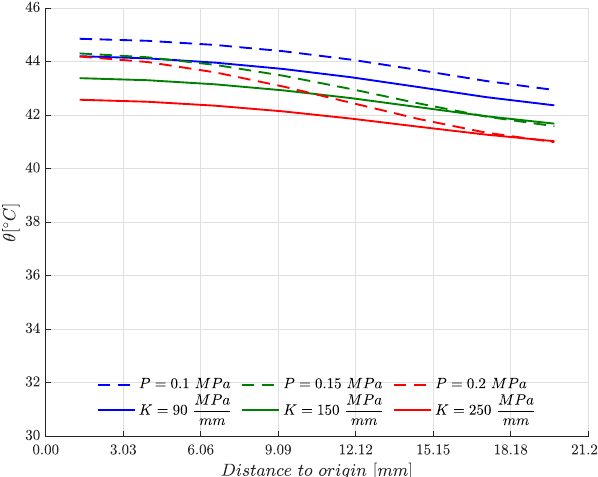
Figure 11. Temperature distribution comparison at the elements located at the diagonal of the base of the microprocessor for the uniform clamping pressure and Winkler elastic